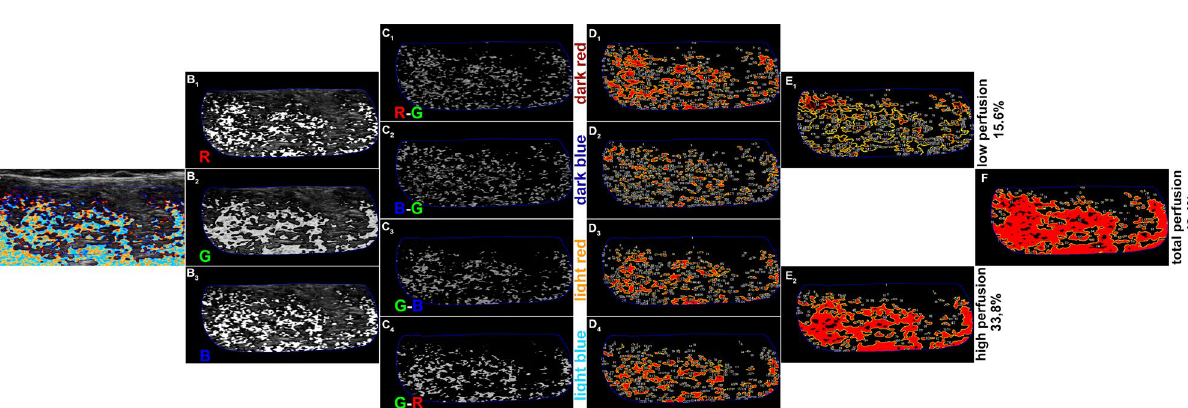
Figure 3. Analysis of color doppler myosonographs ( A ) performed by splitting of the channels ( B ), image subtraction steps ( C ) and signal selection of low and high velocity signals for both directions of blood perfusion ( D ). By creating maximum projections, direction-independent signals were achieved, but since the low velocity perfusion signal includes high velocity perfusion signal (see Supplemental Fig. S1D), the low velocity signal was corrected by subtraction of the high-velocity perfusion signal ( E 1 ). Subsequently, the corrected low velocity perfusion signal ( E 1 ) and the high velocity perfusion signal ( E 2 ) were merged in a maximum projection to gain the signal for the total blood perfusion of the muscle ( F